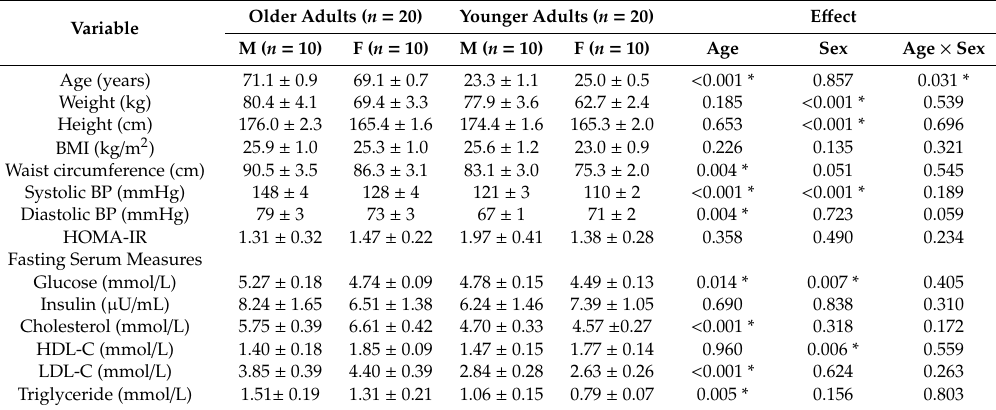
Figure 1. Consort flow diagram of study participant recruitment, intervention, follow ‐ up, and analysis. Table 3. Baseline characteristics and biochemistry of the study participants at fasting.